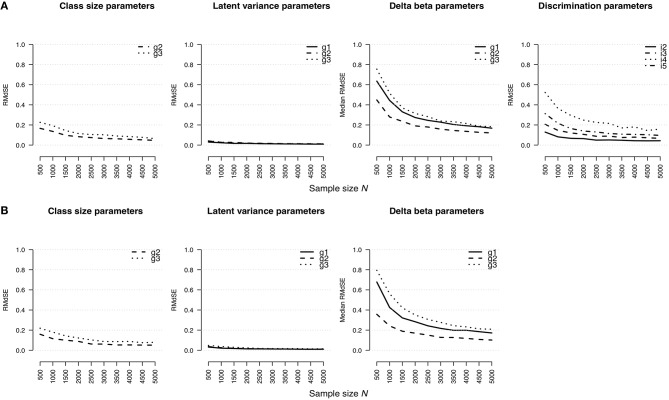
Root median squared error for parameter estimates in (A) the rmGPCM-3 and (B) the mPCM-3 under the condition of a three-class mixture and a 5-item scale with 11 categories.